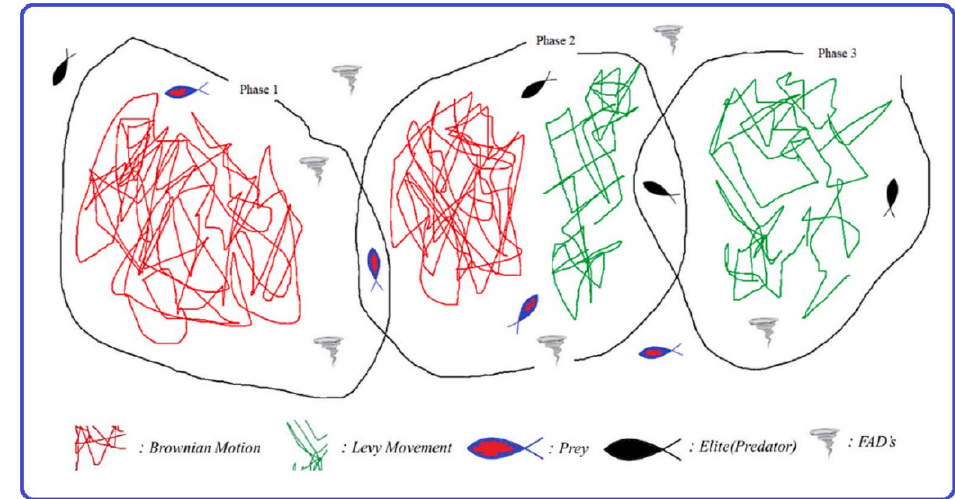
Figure 5. Three phases in marine predator algorithm (MPA) optimization.